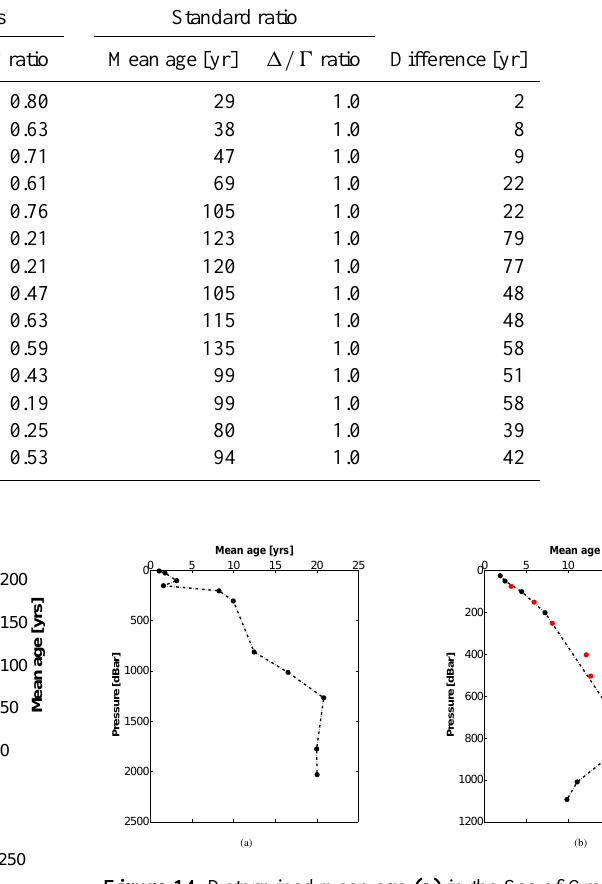
Figure 14. Determined mean age (a) in the Sea of Crete at station Fig. 14: Determined mean age, ( a ) in the Cretan Sea at station 288 and ( b ) in the Adriatic Sea at station 313 based on SF 6 288 and (b) in the Adriatic Sea at station 313 based on SF 6 and andanIG-TTDconstrainedbythetransienttracercoupleCFC-12andSF 6 .ThereddotsshowSF 6 meanageresultswitha differenceofmorethan5yearscomparedtotheCFC-12meanage(i.e.non-constrainedmeanage). an IG-TTD constrained by the transient tracer couple CFC-12 and SF 6 . The red dots show SF 6 mean age results with a difference of more than 5 years compared to the CFC-12 mean age (i.e., non- constrained mean